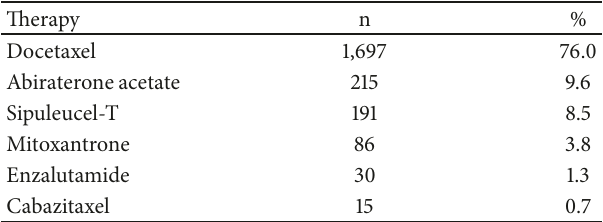
Table 4: Second-line therapies indicating castration-resistant prostate cancer (N =